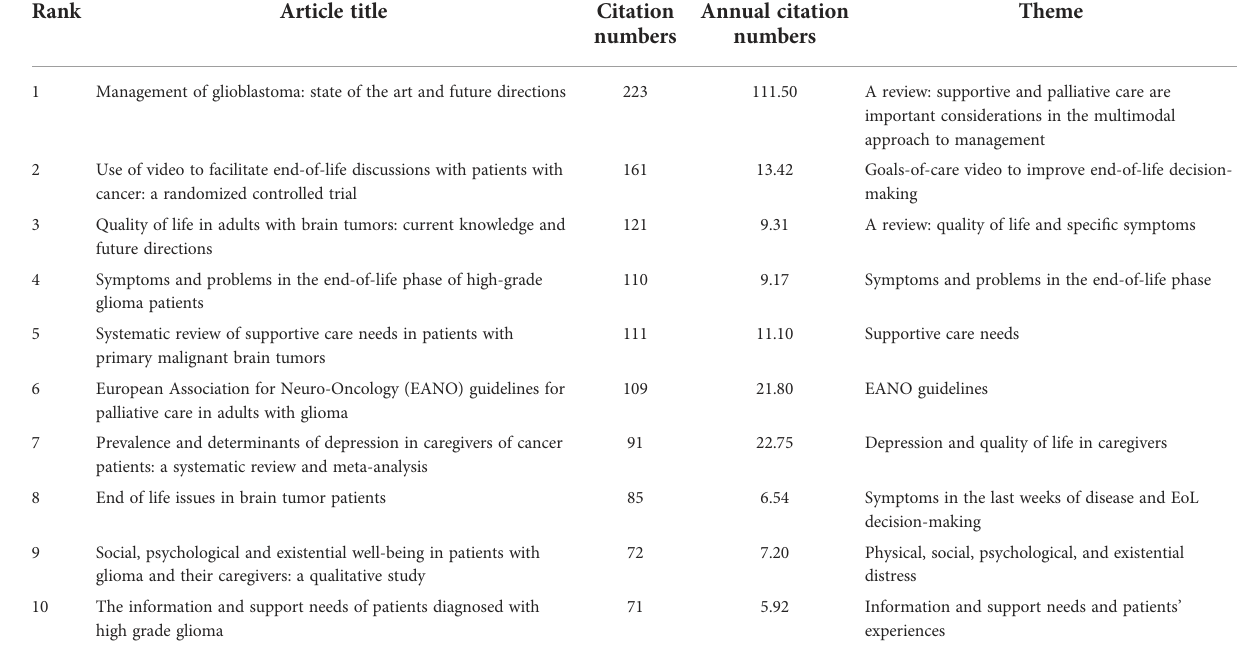
TABLE 2 Summary of the top 10 cited articles on palliative for patients with glioma.